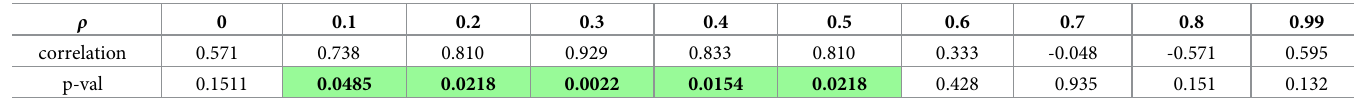
Table 2. Spearman’s correlations between BDDLSdiff and UPDRS score OFF medication. Values are presented as a function of the GWR surrogate level ρ . P-values in bold are smaller than 5%, while green indicates significance under FDR control. Predictors and hemibody UPDRS OFF are averaged across sides ( n = 8, d . f . =